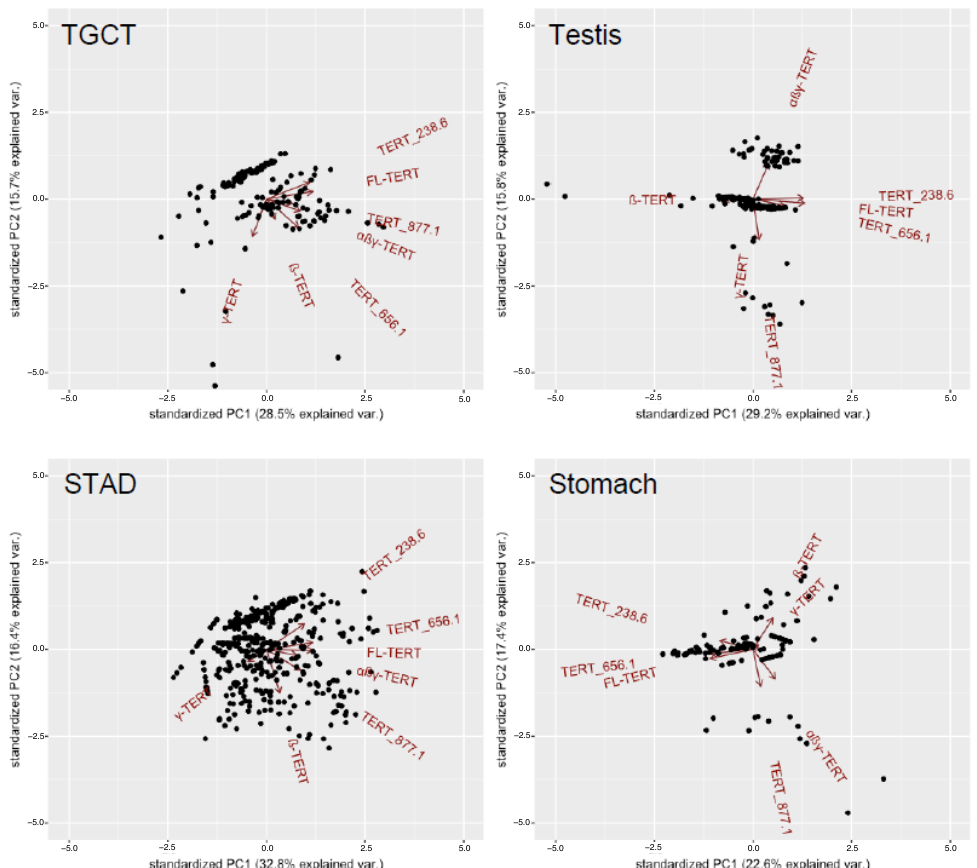
Figure 3. Expression relationships between TERT isoforms differ between tissue types and when in the neoplastic state. PCA biplots for testicular germ cell tumours (TGCT), stomach adenocarcinoma (STAD), and their respective matched normal tissues are shown as examples. Plotted using the first two principal components and show the loading vectors (arrows) of each TERT isoform variable expressed. The arrow length approximates the variance of the variable. The angle between arrows approximates the correlations between variables. Such that parallel arrows in the same direction have positive correlations, perpendicular arrows have no/weak correlations, and parallel arrows in the opposite direction have negative